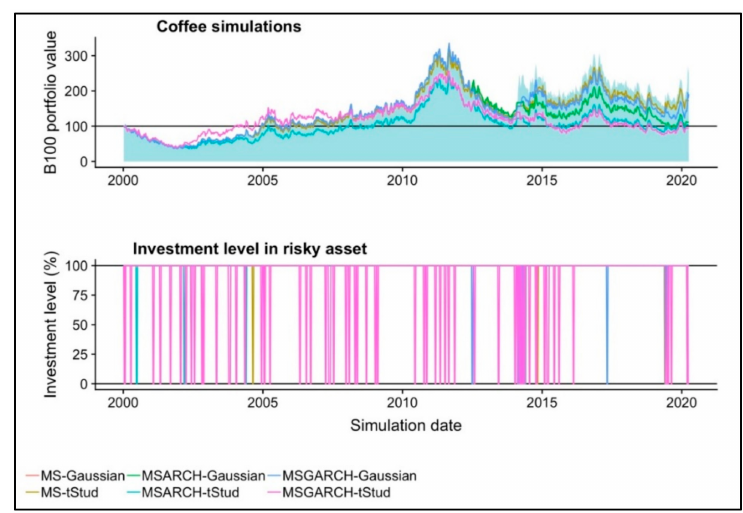
Figure 5. The historical performance and commodity investment level in each of the six simulated portfolios in the one-month co ff ee future